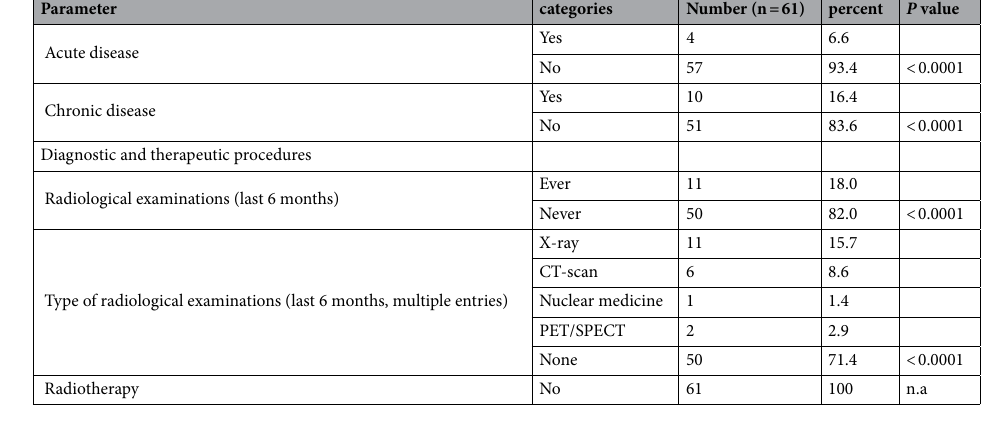
Table 1. The table summarizes the characteristics of all 61 donors such as demographics (e.g. sex, age), social habits (e.g. alcohol, cigarette consumption), oral hygiene (e.g. flossing, mouth wash), acute/chronic diseases and previous radiological procedures (e.g. number of CT-scans). Shown are the numbers per group with descriptive statistics where appropriate (n, mean, minimum [min], maximum [max], standard deviation [stdev] and standard error of the mean [sem]), the percentage per category and the corresponding P values (chi-square test).